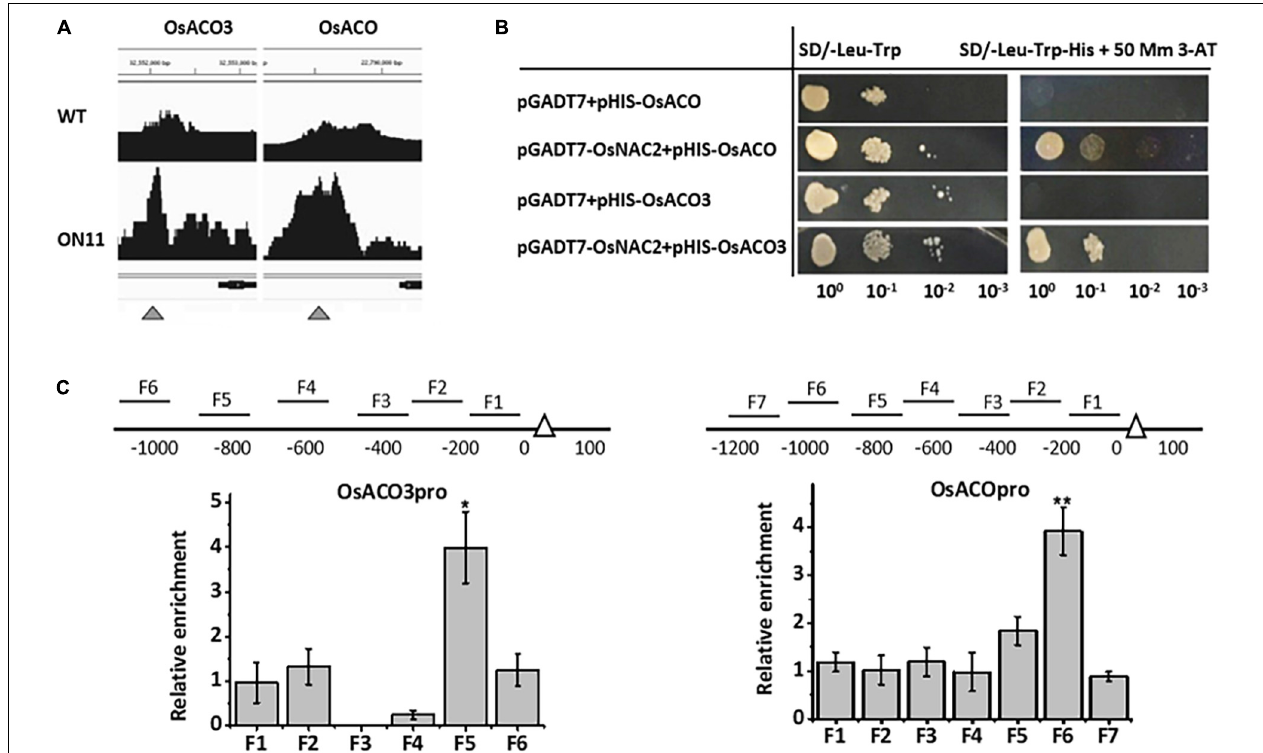
FIGURE 2 | OsNAC2 directly regulates ethylene synthesis–related genes. (A) Binding peaks of OsACO and OsACO3 promoters in the chromatin immunoprecipitation (ChIP)-sequencing assay. Black peaks represent the sequence hits in each gene region. The peak height corresponds to the extent of the binding in a particular region. Bars above the peaks indicate the distance from the ATG start codon of each gene. The scale was 500 bp. The black bar under the peaks represents the coding sequence of each gene, with arrows indicating the direction. (B) Interaction between OsNAC2 and OsACO and OsACO3 promoters by using yeast one-hybrid assay. The yeast cells were grown on SD/-Leu/-Trp/-His/ + 30 mM 3-amino-1,2,4-triazole medium. (C) ChIP–quantitative polymerase chain reaction (qPCR) assay to confirm the binding of OsNAC2 to OsACO and OsACO3 promoters. Total protein extracted from 35S:OsNAC2-mGFP transgenic seedlings were immunoprecipitated with an anti–green fluorescent protein (GFP) antibody. Fragmented genomic DNA was eluted from the protein–DNA complexes and subjected to the quantitative polymerase chain reaction (qPCR) analysis. The long black bars represent promoter regions for which we designed primers. The numbers under the bar show the distance from the ATG start codon. Short bars represent the corresponding region of each pair of primers on the promoter. Error bars represent the standard error of three biological replicates. * p < 0.05 and ** p < 0.01.